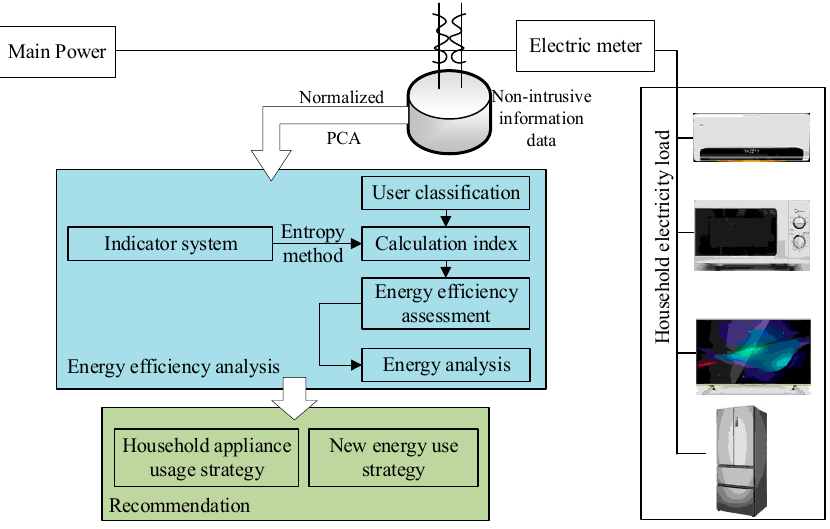
Figure 2. Energy efficiency assessment structure diagram based on NILM technology